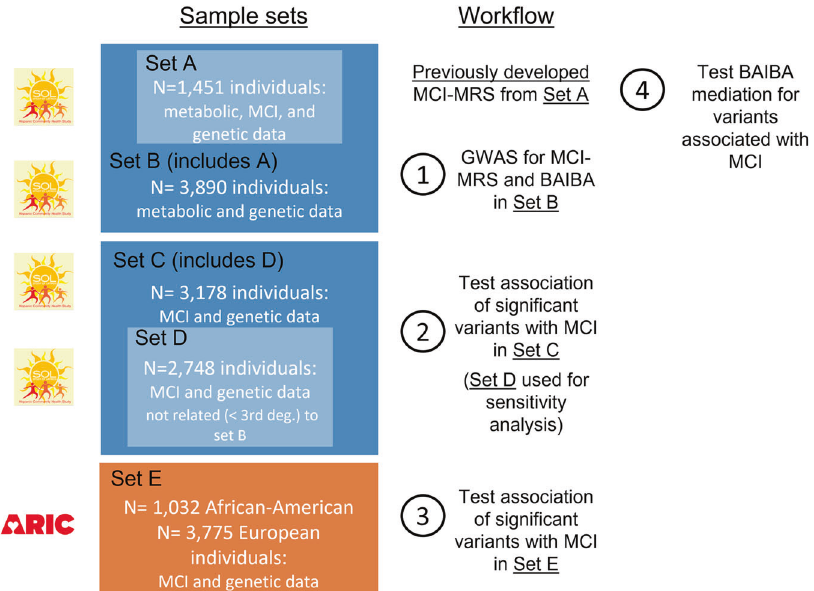
Fig. 1 Analysis fl owchart and the corresponding HCHS/SOL and ARIC analytic datasets. We performed a multi-step analysis. Step 1: Identi fi cation of genetic associations with the MCI-MRS and BAIBA. Step 2: Association testing of the signi fi cantly associated genetic variants with MCI in a separate subset of US Hispanic/Latino older adults. Step 3: Assessment of generalizability of the genetic associations with MCI in European and African Americans from the Atherosclerosis Risk in Communities (ARIC) study. Step 4: Assessment of the mediation effect of BAIBA in the association of the genetic variants with